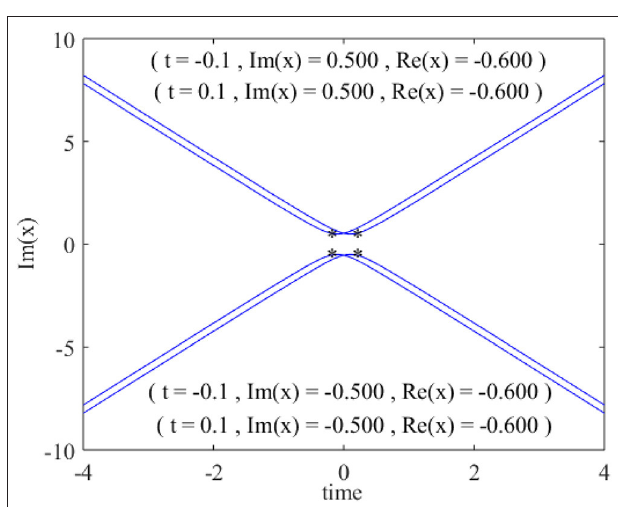
FIGURE 3 | The trajectories of poles in the complex x plane, i.e., zeros of the denominator D 00 of Equation (4) to Equation (6): imaginary part of the poles vs. time t . At the turning points of the curves, the real part of the pole is − 0.600, which is the spatial location of the point of maximum height in physical